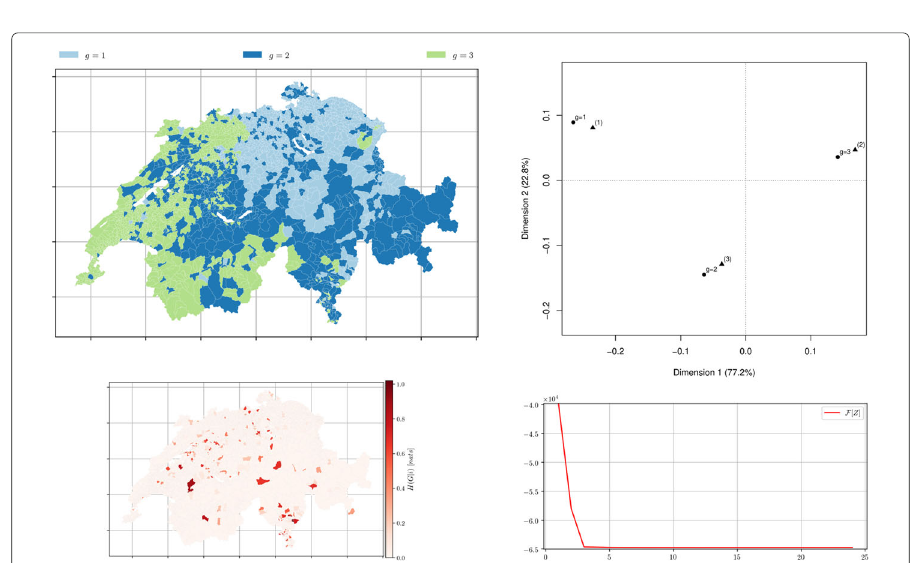
Fig. 12 Municipalitiessoftclusteringonallthetopics depicts the semi-supervised hard assignment obtained from the k-means performed over the therm-frequency distances with θ = 1.01 on the Z 0 for m = 3 groups using χ 2 distances D obtained from topic modelling with k = 3 after 39 iterations. Lefttop Hard membership. Leftbottom the conditional entropy of topics H ( R | i ) showing municipality-topic probability distribution uncertainty. Righttop CA bi-plot between Z ∞ ( • ) and the official classification ( (cid:2) ) with m = 3. Rightbottom The free-energy plot ( β = 20, α =